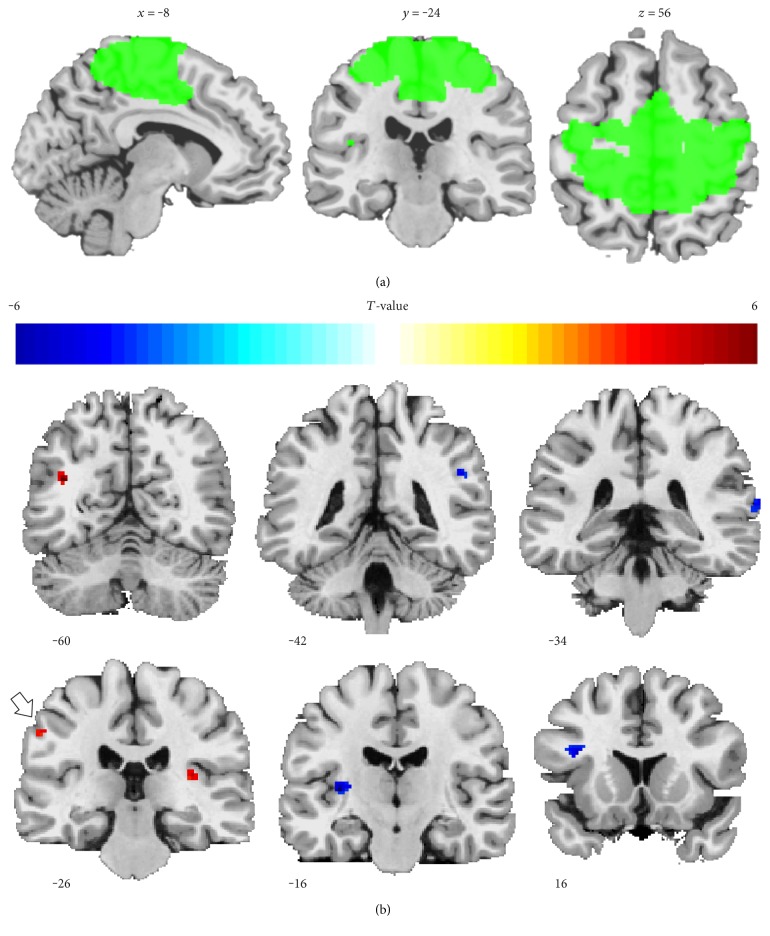
Sensorimotor network component and longitudinal changes in intrinsic network connectivity. (a) Representative sagittal, coronal, and axial slices of the ICA-extracted sensorimotor resting-state pattern on a brain template. The pattern (green) was estimated from a group of 18 subjects. The resulting binary image shows z-scaled network connectivity thresholded at z > 1 in neurological convention, with coordinates referring to x, y, and z in mm MNI space. (b) GLM analysis of changing iFCSEMO after rSS at Punc. < 0.001 (k > 10 vx). Regions of higher iFC are plotted in red, whereas regions of lower iFC are plotted in blue. An arrow marks the cluster at the left postcentral gyrus (BA 3) which survived a small volume correction (10 mm sphere at x/y/z = −55/−22/41; PFWE = 0.016). Coordinates refer to x, y, and z in mm MNI space and neurological convention.